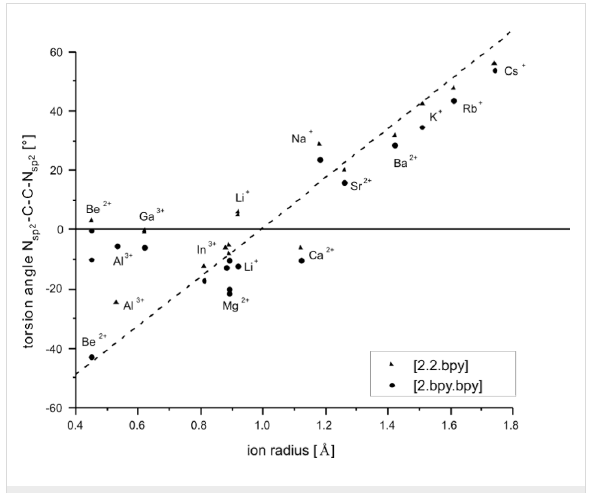
Figure 13: RB3LYP/LANL2DZp torsion angle N sp2 –C–C–N sp2 for [M 2.2.bpy] m+ and [M 2.bpy.bpy] m+ plotted against the ionic radius of M m+ (dashed line represents the observed